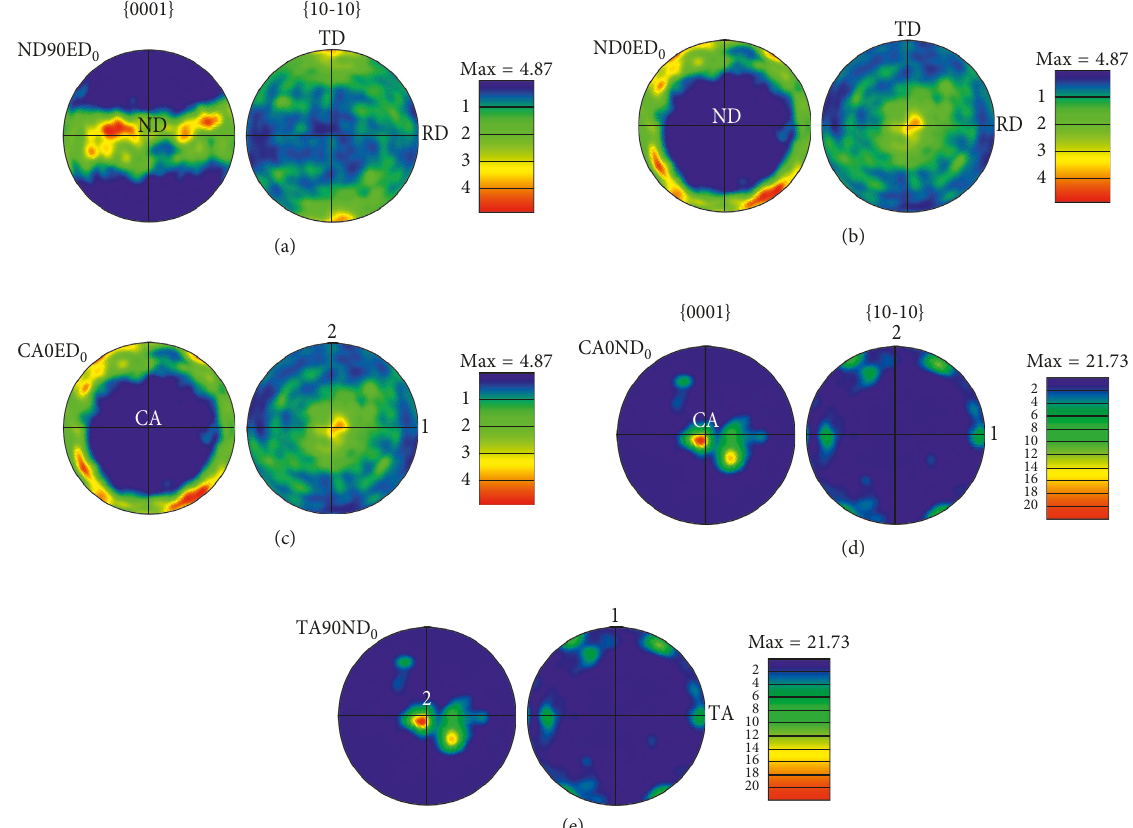
Figure 5: { 0001 } and { 1010 } pole figures of the initial texture for the five set of samples shown in Figure 1 using the reference frame for each mechanical test: (RD, TD, ND) for PSC, (1, 2, CA) for simple compression and (1, 2, TA) for uniaxial tension, where 1 and 2 refer to the lateral directions of the compression or tension test. The pole figures were obtained by appropriate rotations of the pole figures shown in Figure 4 with respect to the new reference frame. (a) ND90ED 0 . (b) ND0ED 0 . (c) CA0ED 0 . (d) CA0ND 0 . (e) TA90ND 0